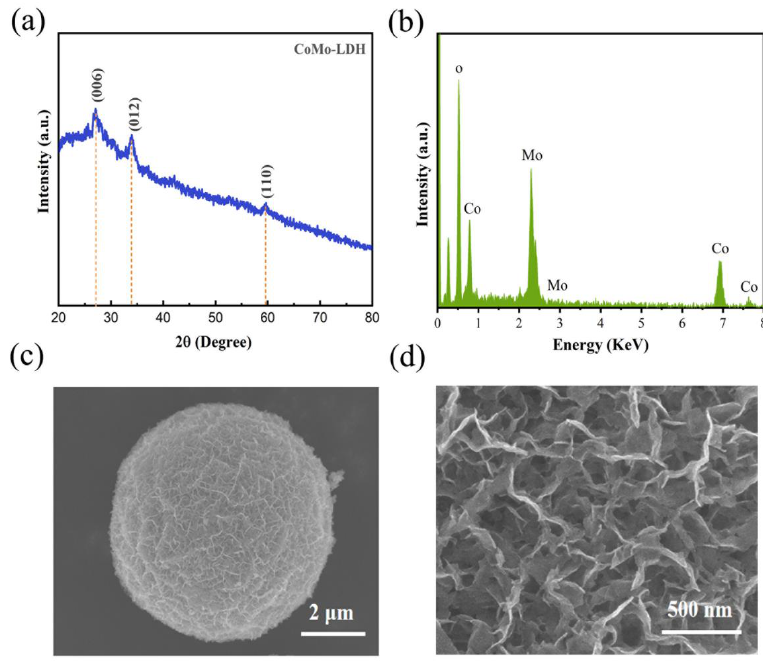
Figure 1. ( a ) XRD pattern; ( b ) EDS analysis; ( c , d ) SEM images of